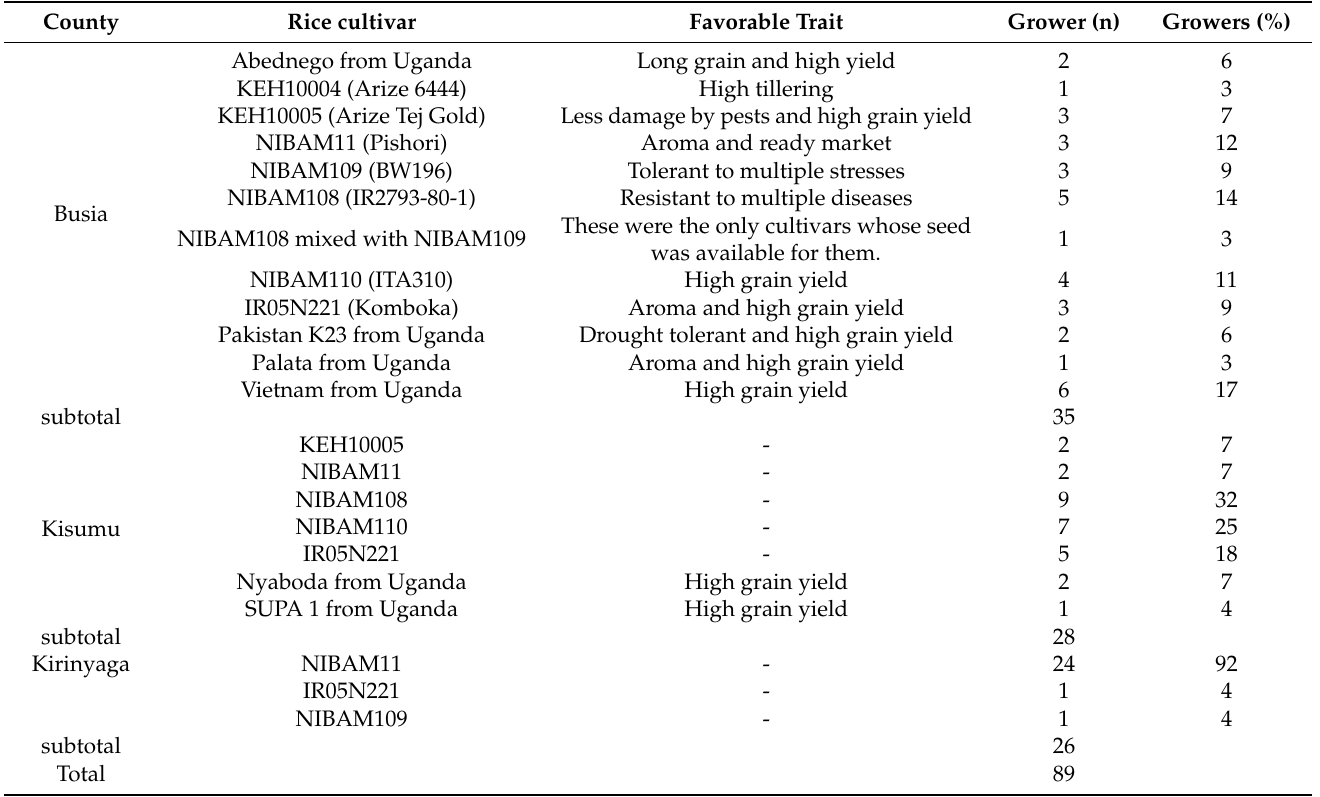
Table 2. Percentages of farmers who preferred key traits of rice cultivars that were surveyed in Busia, Kirinyaga, and Kisumu Counties of Kenya in